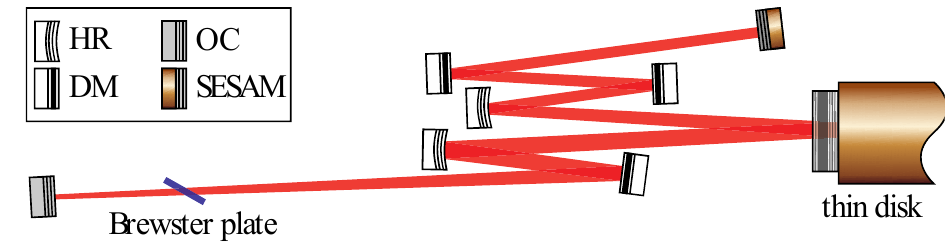
Figure 2. Typical layout of a modelocked TDL cavity. HR: highly-reflective mirror, OC: output coupling mirror, DM: dispersive mirror.